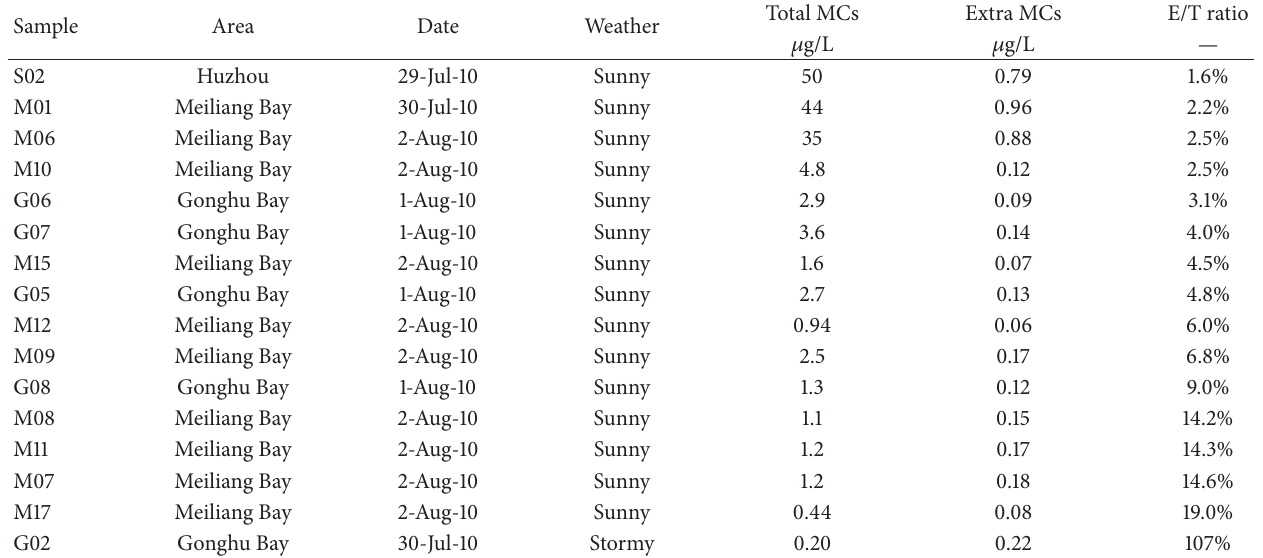
Table 2: Calculated E/T